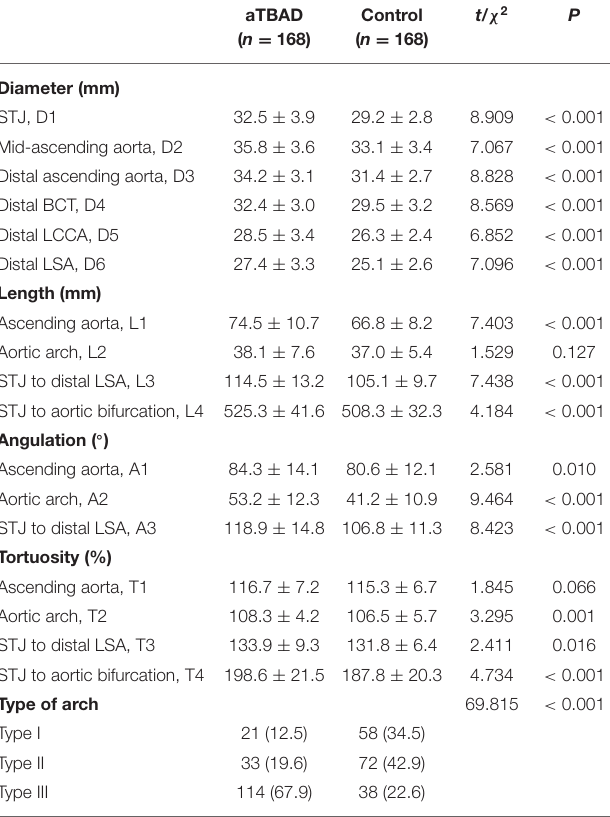
TABLE 2 | Geometric variables of the ascending aorta and aortic arch in aTBAD and control